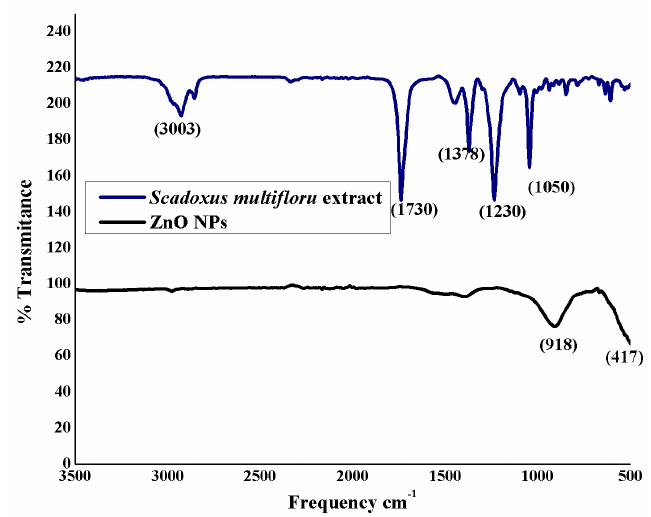
Figure 2. FTIR analysis of ZnO nanoparticles and extract.